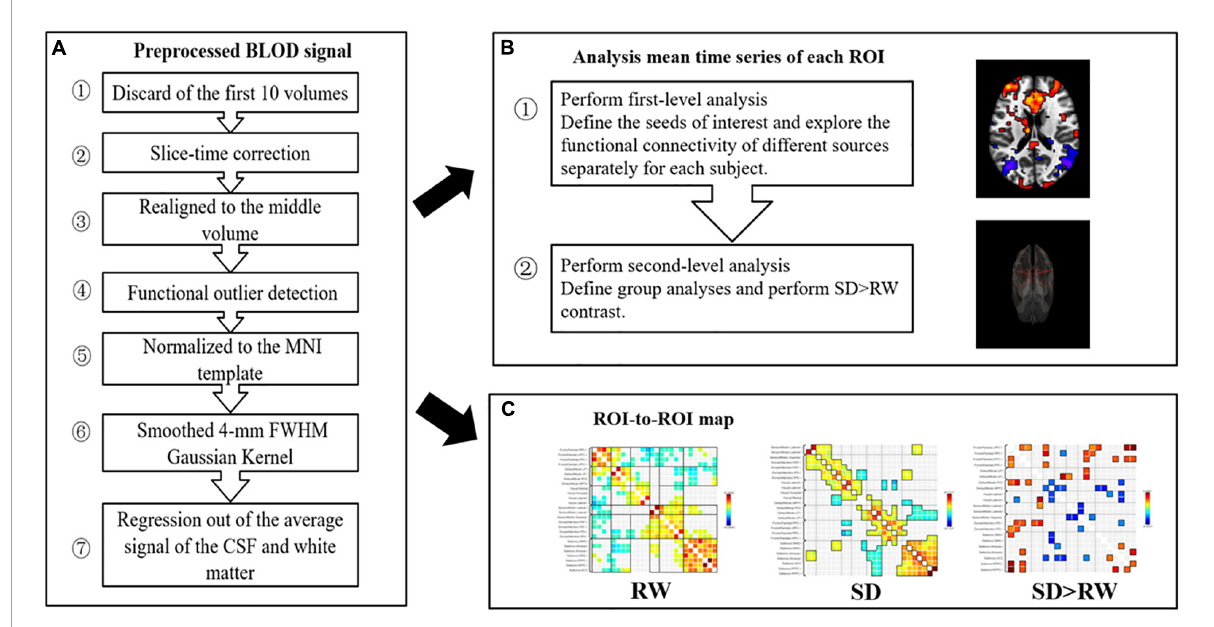
FIGURE3 Preprocessing and analysis pipeline. (A) Preprocessing pipeline; (B) analysis pipeline: first and second level analyses; (C) ROI-to-ROI map: 26 regions of interest (ROis) were selected from the six large scale networks: default mode network (DMN), sensorimotor network (SMN), visual network (VN), salience network (SN), dorsal attention network (DAN), ventral attention and frontal-parietal control network (FPN), SN as the seed, ROI-to-ROI analysis. SD, sleep deprivation; RW, rested wakefulness; ROI, regions of